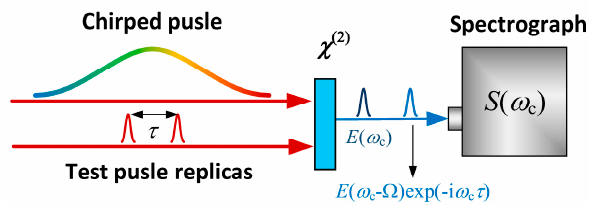
Figure 4. Schematic of SPIDER. χ (2) is a nonlinear crystal. The fundamental (FH) pulse replicas are Fig. 4 frequency-conversed in the nonlinear crystal with a shear Ω